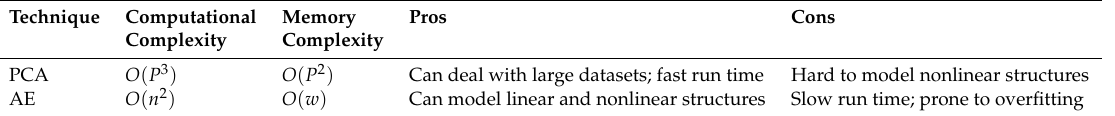
Table 1. Properties of analyzed approaches for dimensionality reduction